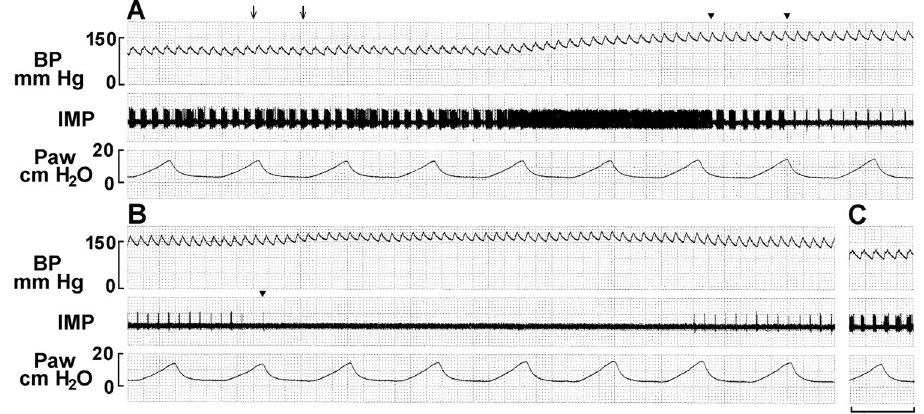
Figure 10. Baroreceptor unit response to phenylephrine injection (2 arrows at the beginning of A). Blood pressure increased approximately 6 s thereafter, during which time the unit deactivated in three steps (denoted by 3 arrow heads at the end of A and beginning of B), indicating at least 3 encoders in this unit. Complete deactivation occurred at the last arrow head, induced by injection of blood into the artery (starting immediately before the last arrow head) and re-activated as blood withdrawn. C is